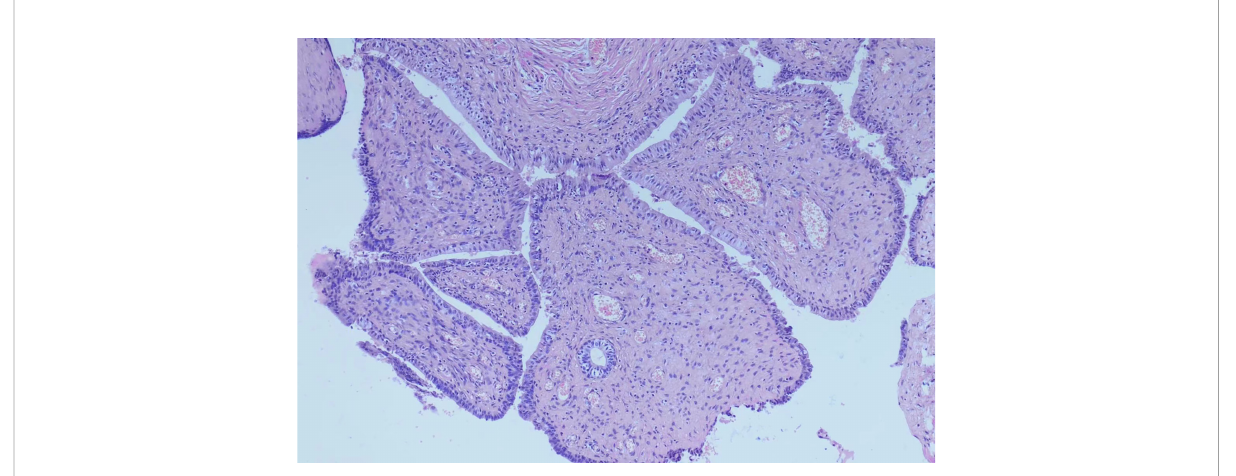
FIGURE 2 Microscopically, tumor histology revealed fi brous components (mostly) and epithelial components, without atypia. Immunohistochemical results were:CK (+), Vim (+), GATA3 (+), PAX -8(+), CD34 (vessel+), bcl- 2(+), SMA (-), ER (mesenchy me+), PR (mesenchyme+), ki67(+, about